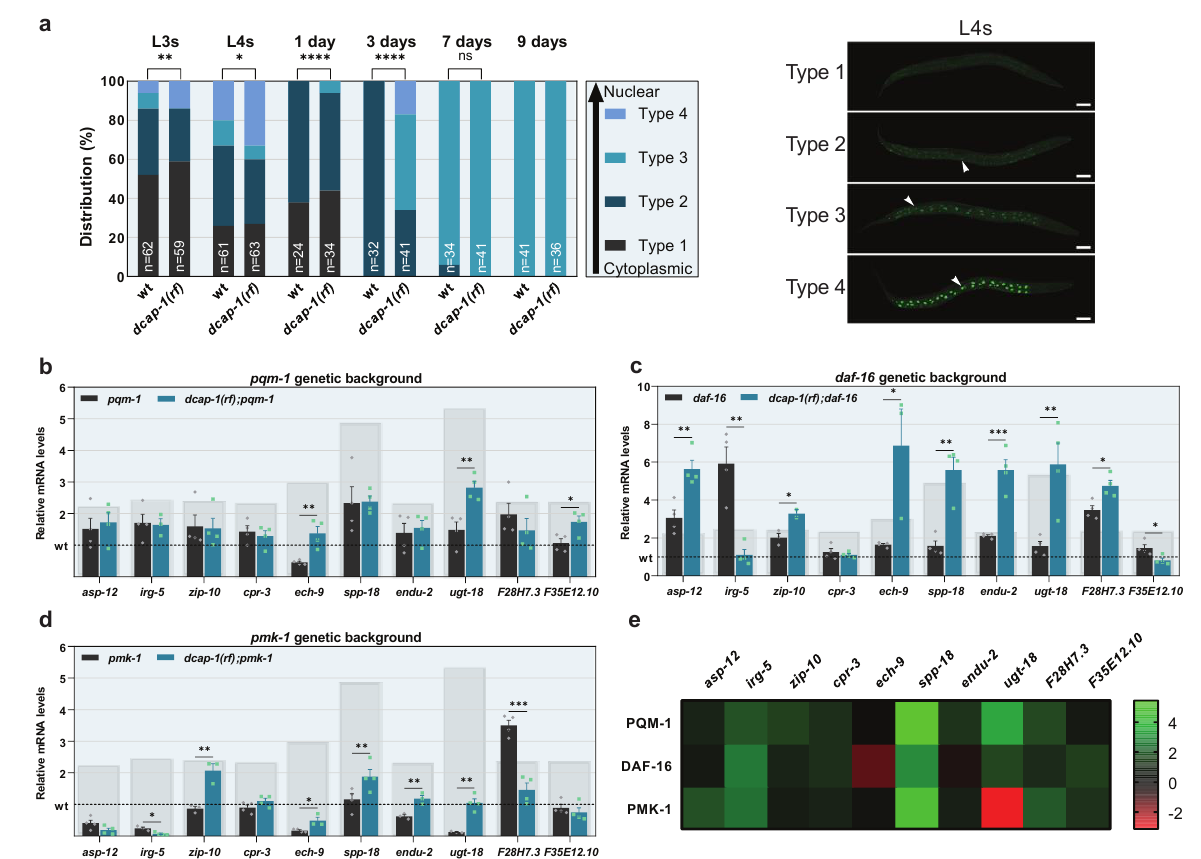
Figure 3. DCAP-1 dysfunction activates PQM-1 and leads to the induction of immunity genes during ageing. ( a ) Distribution of wt and dcap-1(rf) worms according the degree of PQM-1 nuclear localization at various ages. n = number of worms. Images (maximum projections of confocal stacks) correspond to L4 worms, categorized depending on the degree of PQM-1 nuclear localization. White arrows point to nuclei. Scale bar = 50 µ m. See also Figure S3. ( b – d ) Relative mRNA levels of immunity related genes determined by qRT-PCR in 9 day-old worms with pqm-1 , daf-16 or pmk-1 mutant background. Symbols represent individual values. Bars represent mean ± SEM. All values are expressed relative to 9 day-old wt animals (dashed line). Grey rectangular backgrounds correspond to mRNA levels in single dcap-1(rf) mutants. ( e ) Heat map depicting the involvement of PQM-1, DAF-16 and PMK-1 in the differential expression of selected immunity-related genes in a dcap-1(rf) mutant background. Values correspond to differences in fold change ( ∆ FC) between single dcap-1(rf) and double pqm-1;dcap-1(rf) , daf-16;dcap-1(rf) and pmk-1;dcap-1(rf) mutants, compared to their respective controls. Green shades represent a positive effect and red a negative one. * p ≤ 0.05, ** p ≤ 0.01, *** p ≤ 0.001, **** p ≤ 0.0001. Chi-square test ( a ), Unpaired t -tests ( b – d